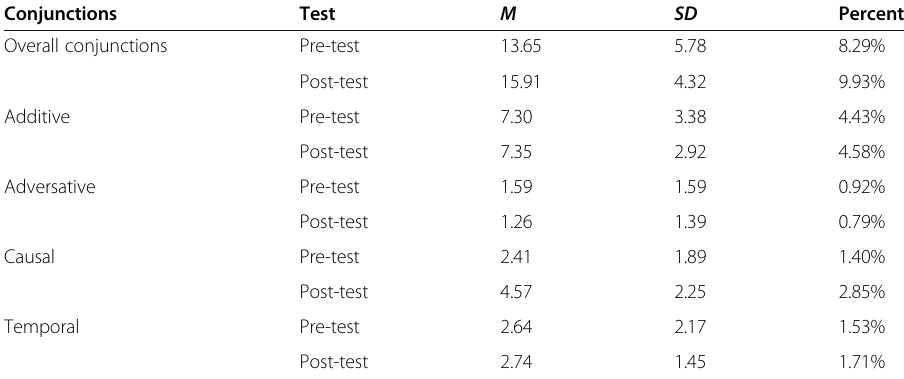
Table 3 Mean frequency, standard deviation and percent of the subcategories of conjunctions Conjunctions